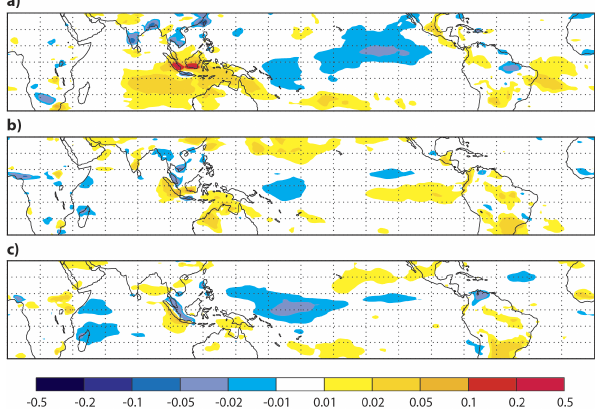
Figure 7. The same as Fig. 5 but for NO x anomaly in ppb.